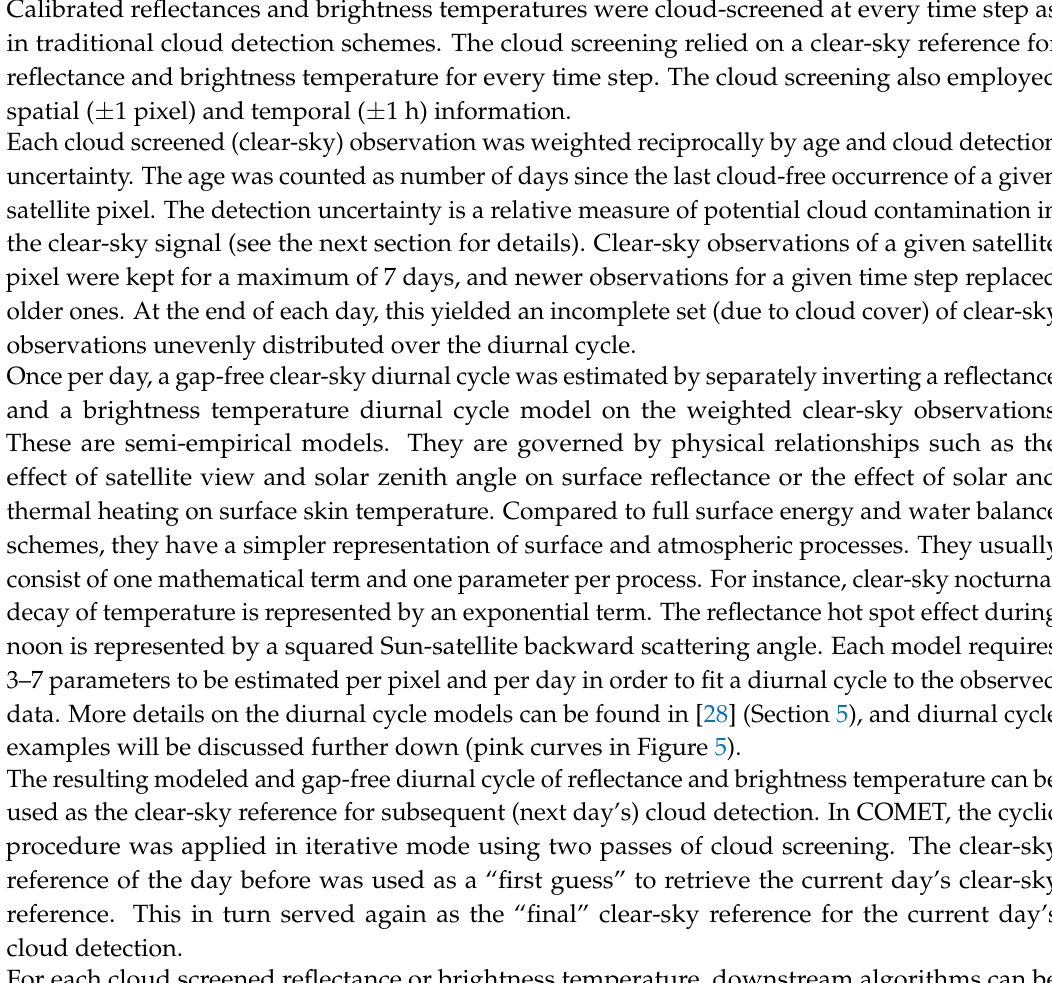
Figure 3 schematically visualizes this “implicit” clear-sky compositing. The following explanation starts from the top and continues in the clockwise direction. Blue numbers in the Figure correspond to the numbered items